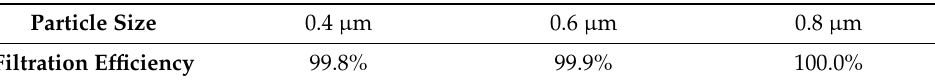
Table 3. Fractional efficiency by particle size.